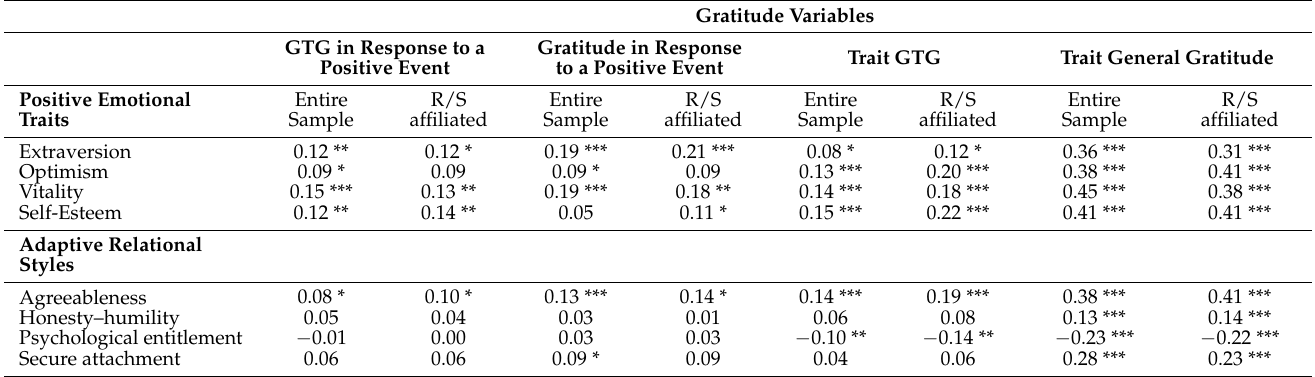
Table 2. Pearson Zero-Order Correlations between Predictors and Gratitude